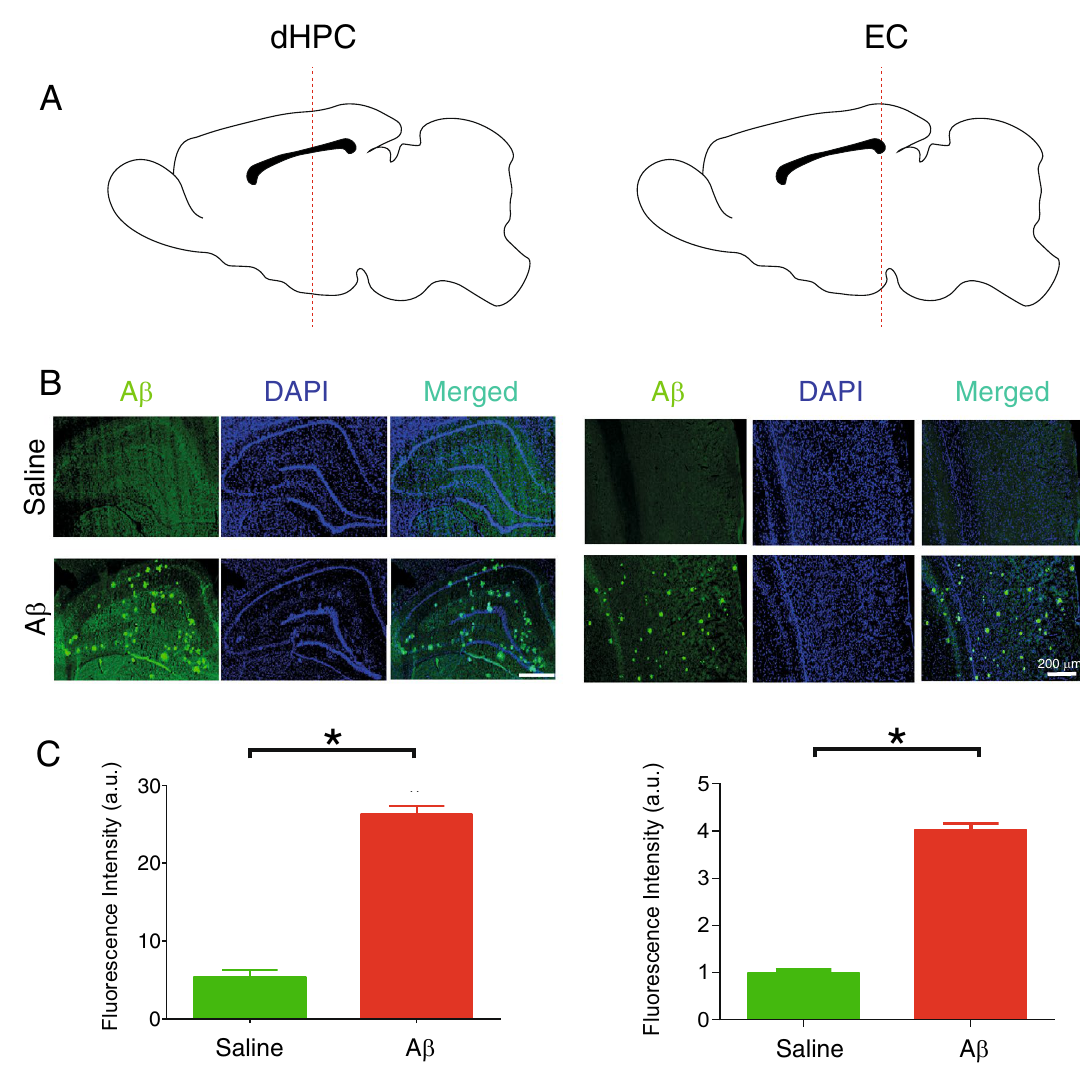
Figure 2. Aβ plaques accumulation in regions of interest of AD model animals. ( A ) Schematic sections for immunostaining in the dHPC and EC ( B ) Immunostaining sections from animals received i.c.v saline and Aβ. Immunostaining of anti-Aβ 1-42 indicated a high level of plaque accumulation in Aβ animals compared to the saline group. (C) Fluorescence intensity (a.u.) is significantly higher in Aβ animals compared to the saline group. White bar scale indicating 200 µm. Aβ amyloid-beta, AD Alzheimer’s disease, DAPI, 4 ′ ,6-diamidino-2- phenylindole; dHPC dorsal hippocampus; a.u., arbitrary